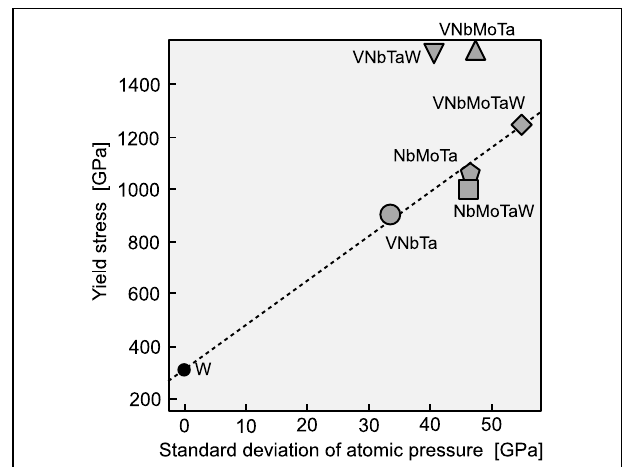
FIGURE 3 | Yield stress versus standard deviation of atomic pressure in various bcc random alloys. The experimental yield stresses were obtained from room-temperature data (Senkov et al. (2011b); Nguyen et al. (2019); Li et al. (2020)). The data point for W represents the critical resolved shear stress that was experimentally observed at 77 K in Argon and Maloof (1966). The broken line connecting W and VNbMoTaW is an eye